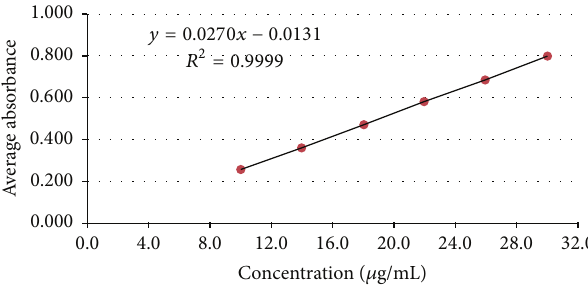
Figure 4: Analytical curve of standard rifaximin, at concentrations of10,14,18,22,26,and30 𝜇 g mL −1 ,obtainedbythespectrophotome- try method in the ultraviolet region in purified water with 20% ethyl